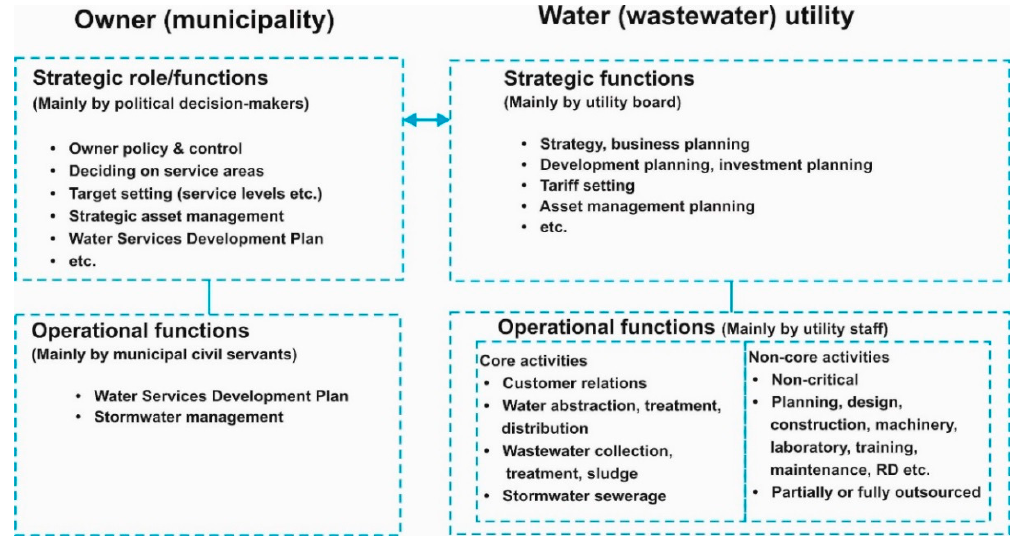
Figure 3. Key strategic roles and functions of municipality and urban water utility in Finland [13] (p. 205).